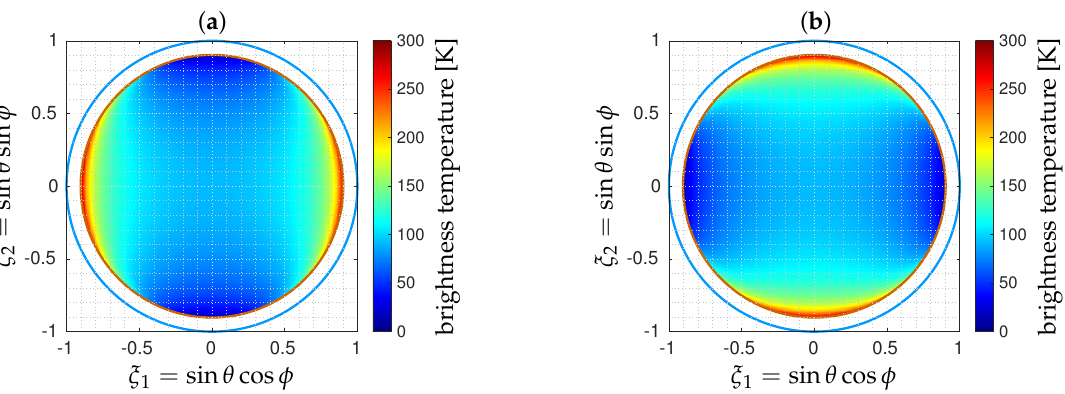
Figure 7. Brightness temperature distributions T of a typical scene over the ocean in ( a ) X and ( b ) Y polarizations at instrument level. Referring back to Figure 2, Earth is here shown with a maroon line from an elevation h = 685 km with a tilt angle (cid:101) = 0 (nadir looking mode, as illustrated in Figure 1). Shown in Figure 8 are the error maps (cid:101) T − T when the shortest spacing d is set to 0.69 λ or to 0.71 λ . As expected, the reconstruction error is almost equal to 0 in both cases, whatever the polarization. In this ideal noiseless situation, the retrieved brightness temperature maps are not sensitive to the spacing between the antennas.